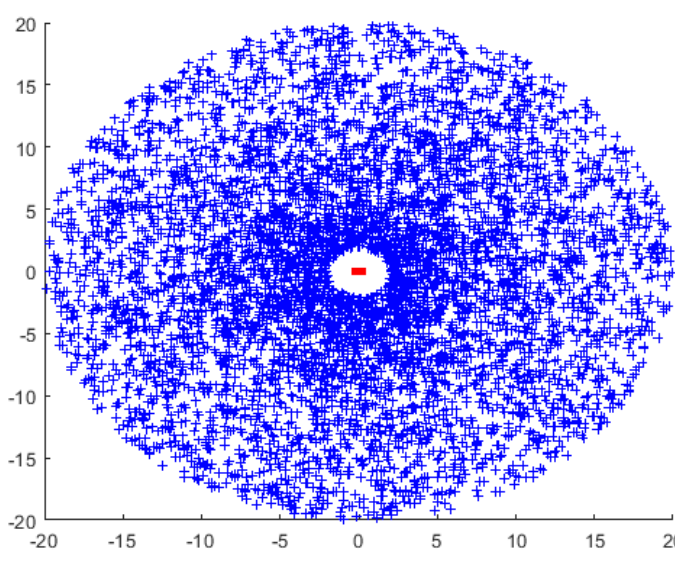
Figure 5. Access point (red) and mobile station (blue) locations for 200